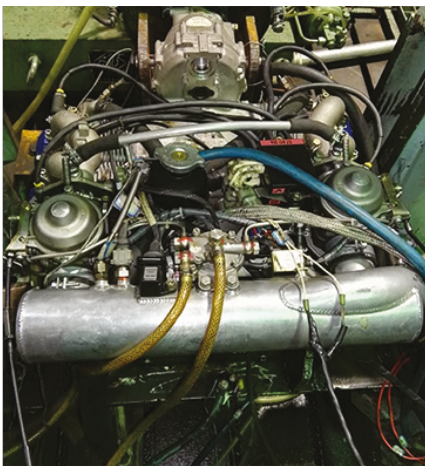
Figure 3: The gasoline engine of UAV with double carburetors. Table 1: Technical parameters of the Rotax gasoline engine.